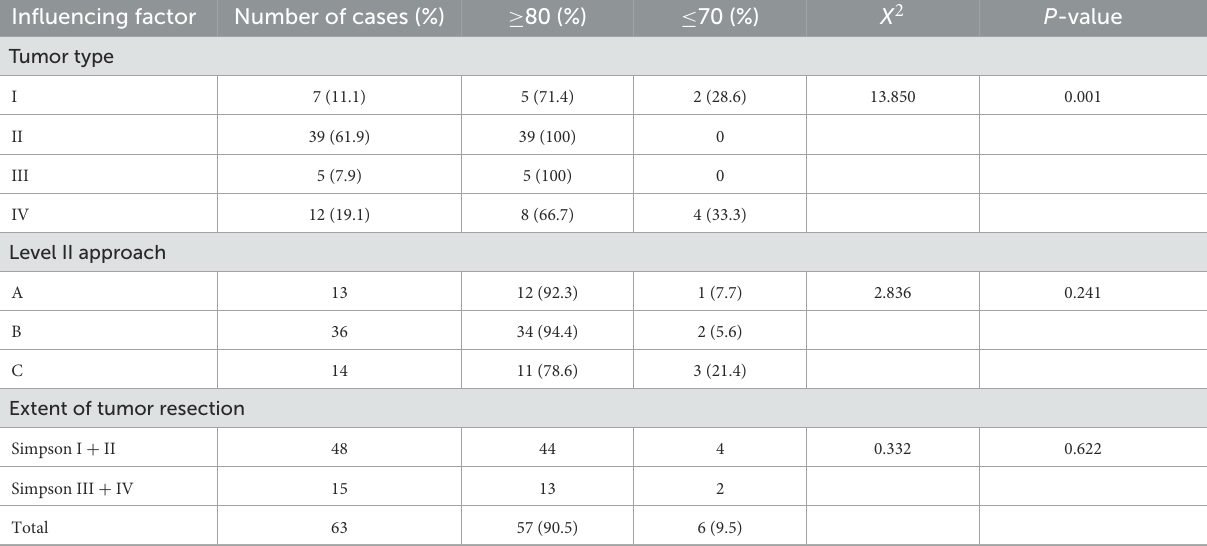
TABLE 6 Analysis of factors influencing quality of life score (KPS; case). Influencing factor Number of cases